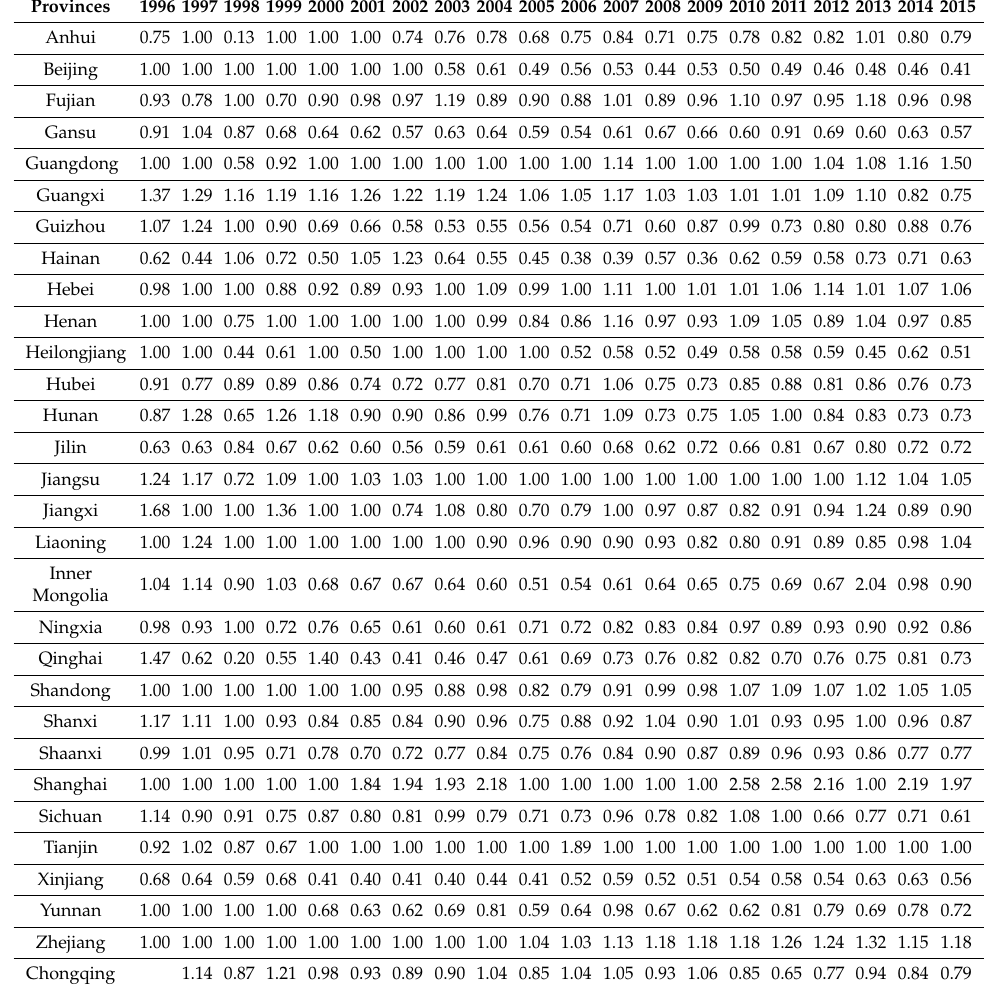
Table A1. China’s provincial environmental production e ffi